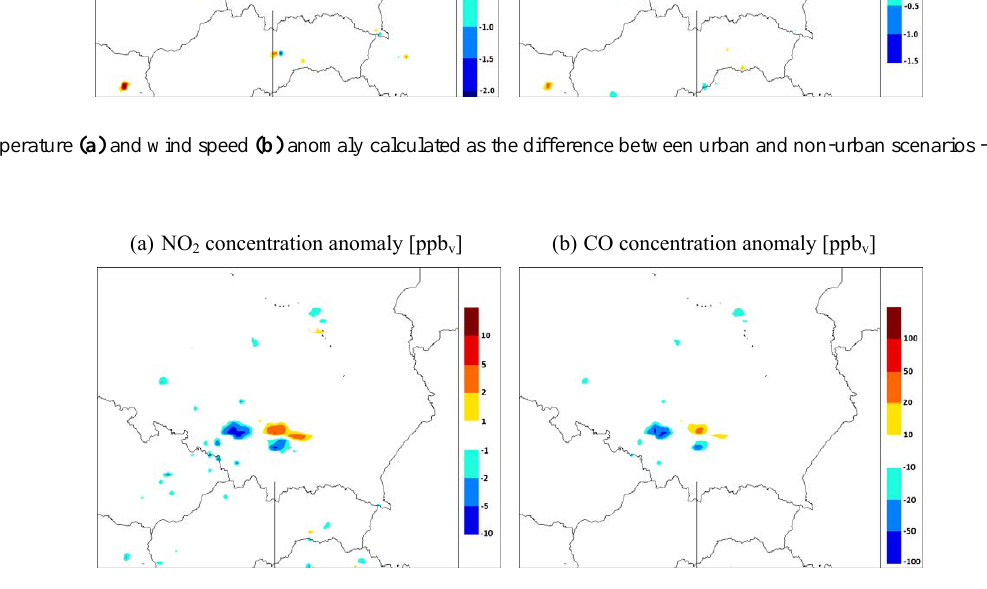
Figure 13. NO 2 (a) and CO (b) concentration anomalies calculated as a difference between urban and non-urban scenarios in the lowest model layer – 29 March 2011,